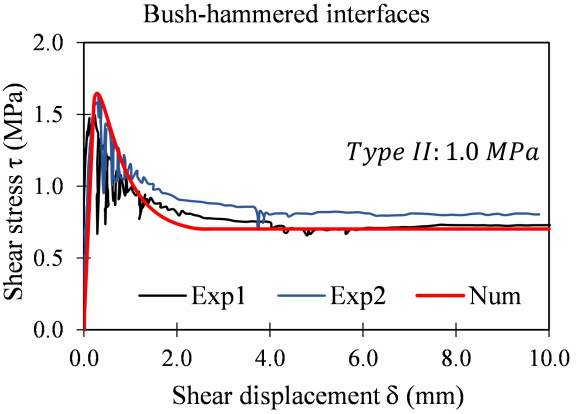
Figure 22. Experimental and numerical tests of bush-hammered interfaces (1.0MPa).